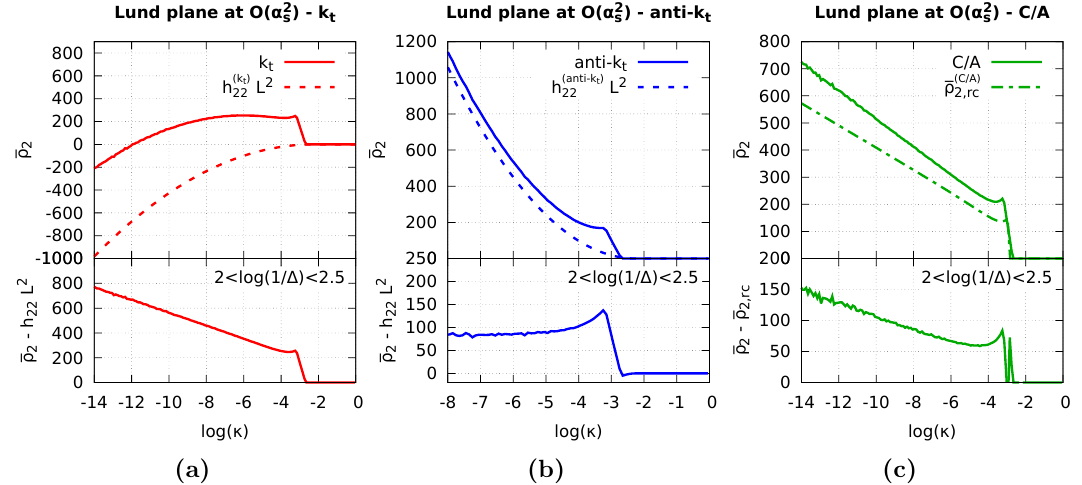
Figure 5. Evaluations with Event2 of the second-order contribution to the Lund plane, in a bin of ln 1 = (cid:1), as a function of (cid:20) , for (de)clustering sequences obtained with the k t , anti- k t and C/A jet algorithms. In (a) and (b) the dashed line corresponds to the analytic expectations, eqs. (2.9) and (2.10) for clustering-induced double-logarithms in the k t and anti- k t algorithms. In (c), for the C/A algorithm, which is seen here to be free of double logarithms, the dot-dashed line corresponds to the (single-logarithmic) running coupling correction, eq. (2.11), illustrating that it dominates the second-order